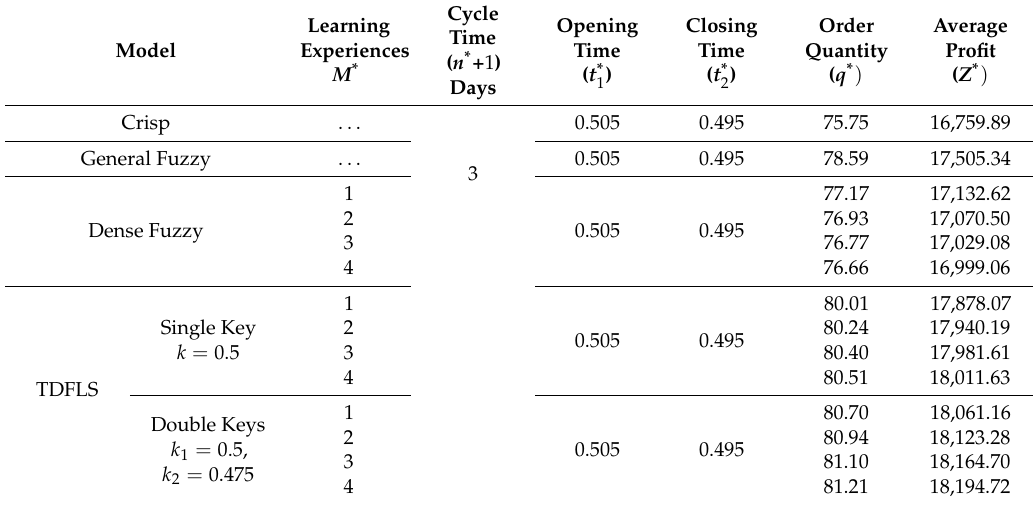
Table 1. Optimal solution of the economic order quantity (EOQ)